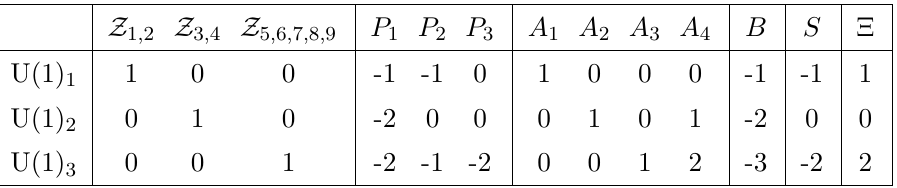
Table 2 . GLSM charges of the monad bundle on CICY